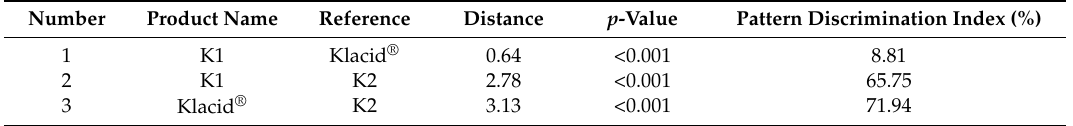
Table 1. Similarities between groups of K2, Klacid ® and K1 using the similarity function of the